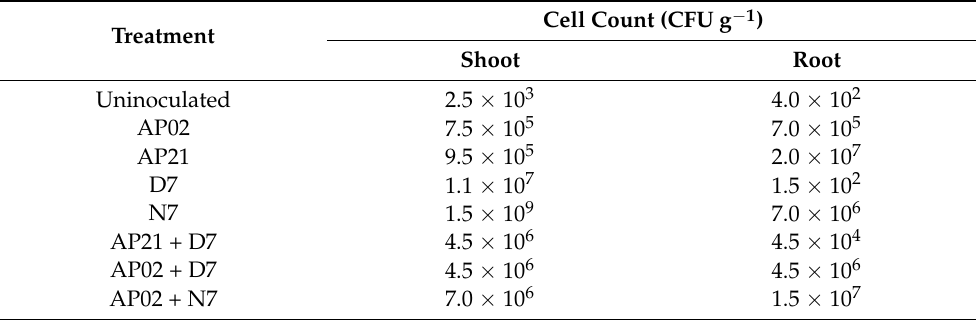
Table 4. Bacterial cell count in semi-solid nitrogen-free medium (NFb) in seven days old ryegrass